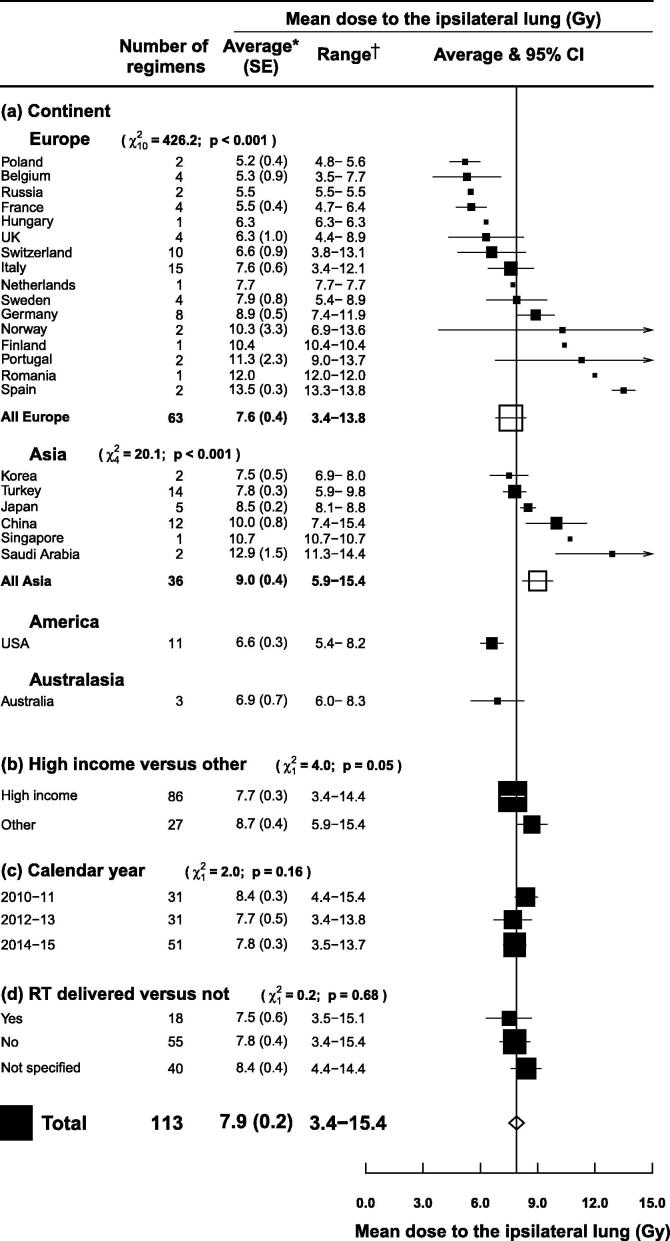
Mean ipsilateral lung dose (MLDipsi) from left or right tangential breast cancer radiotherapy according to country, gross national income per person in the country concerned, calendar year, and whether the radiotherapy plans were actually delivered or just planned. Regimens that irradiated the internal mammary chain, partial breast, axilla, or supraclavicular fossa were excluded, as were regimens with breathing adaptation, prone or lateral decubitus positioning and studies of women with unfavourable anatomy. *Average of mean ipsilateral lung doses for reported regimens. †Range of mean ipsilateral lung doses for reported regimens. χ2 and p values are for: heterogeneity (a), difference (b, d) or trend (c). For (d), the category “Not specified” was omitted from the χ2. Abbreviations: SE: standard error; CI: confidence interval.